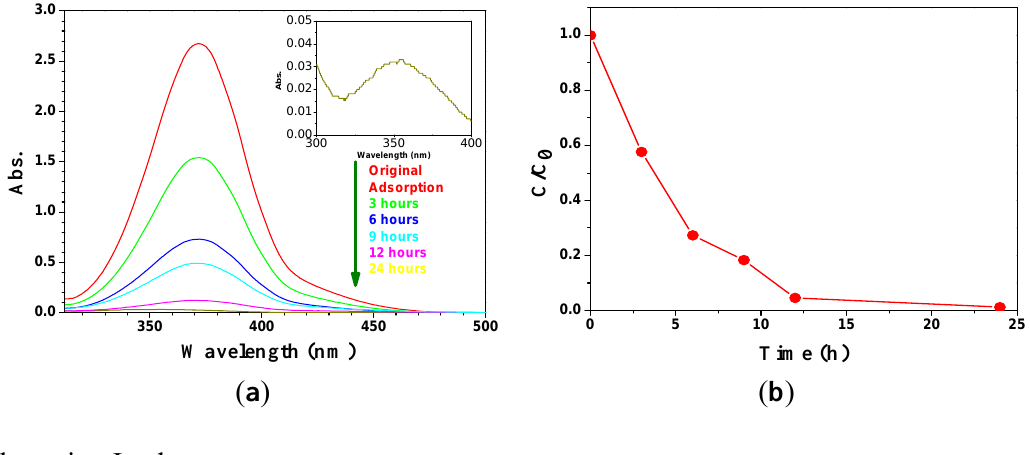
Figure 7. The temporal evolution of UV spectral of Cr(VI) solution at the presence of PVI-TFSI ( a ) and the dependence of concentration of methyl blue on absorption time ( b